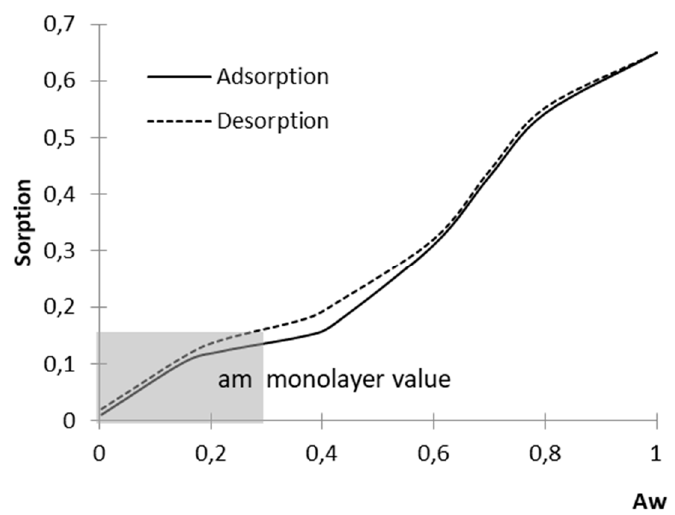
Figure 2. The course of water vapour sorption curves for native starch. Specific surface area was determined from Equation (2) [10,23].